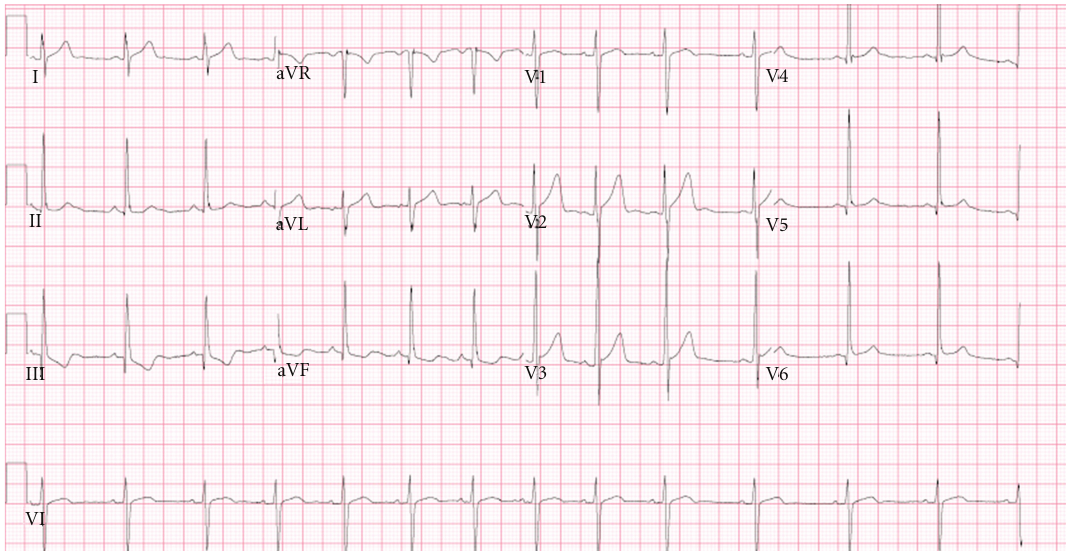
Figure 5: Electrocardiogram 7 days o ff Asacol: normal sinus rhythm and T wave inversion lead